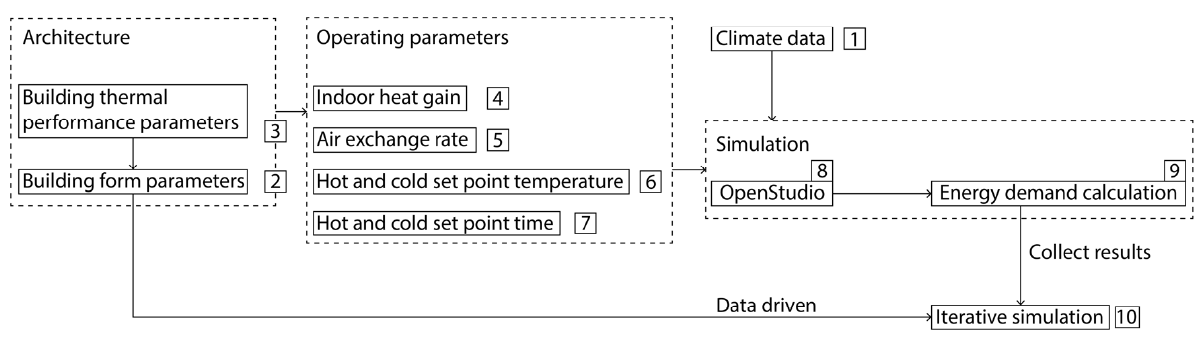
Figure 14. Modeling logic of the Grasshopper